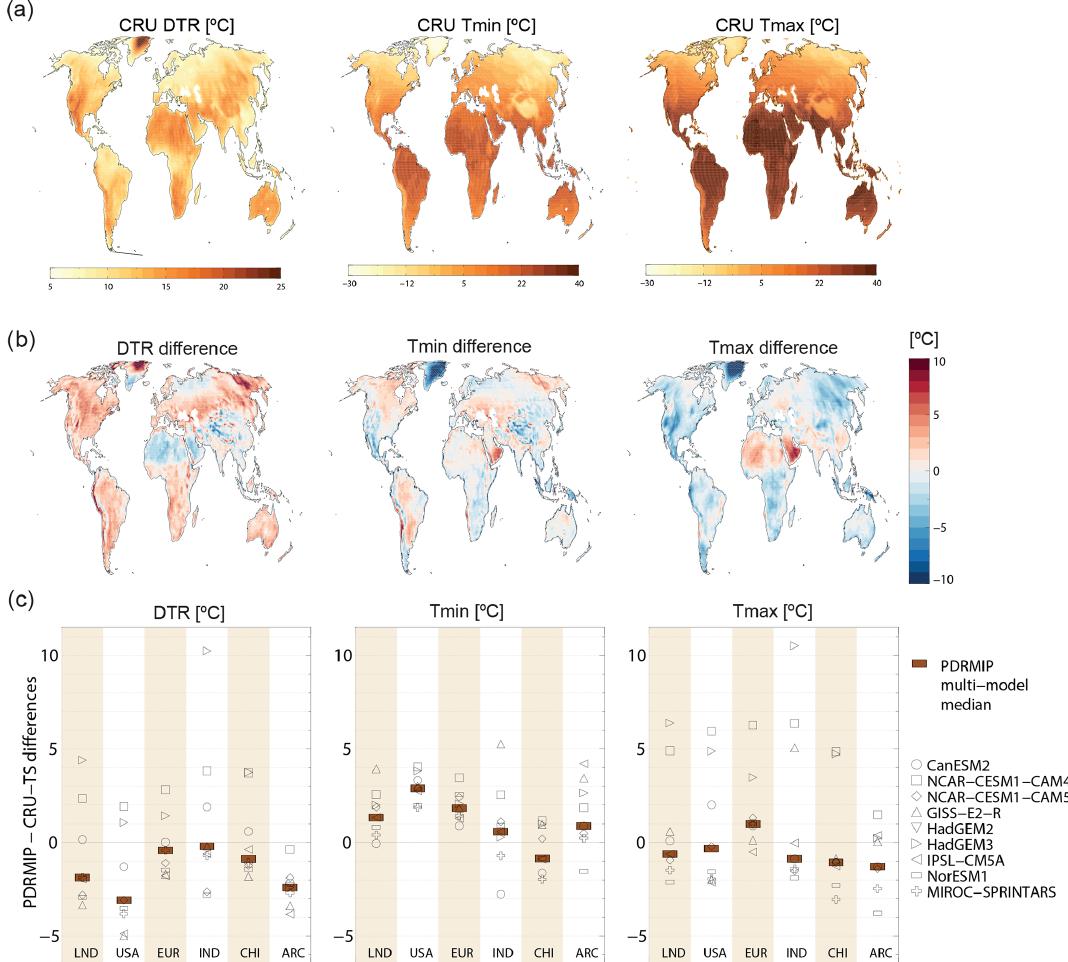
Figure 2. For DTR, T min and T max , the figure shows (a) geographical distribution of CRU TS values, averaged over the years 1991–2010; (b) geographical distribution of differences between the PDRMIP model-median baseline (mean of year nos. 51–100 of 100-year fully coupled simulations) and CRU TS; and (c) regionally averaged differences for the model median and for individual models. Note that as HadGEM2 has a preindustrial baseline in the PDRMIP simulations (Samset et al., 2016), we have omitted this model